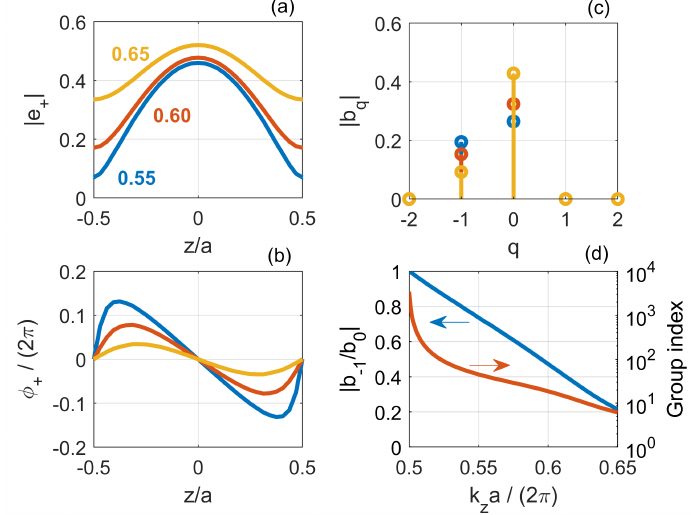
Figure 7. Bloch modes of the line-defect waveguide. ( a ) Magnitude and ( b ) phase of the lateral electric field component of the forward-propagating Bloch mode along the centerline of the waveguide. Each color corresponds to a different value of the wavenumber, which is reported in ( a ) in units of 2 π / a . ( c ) Magnitudes of the spatial Fourier harmonics b q . ( d ) Magnitudes of the ratio between the spatial harmonic of order − 1 and the average (left). Group index